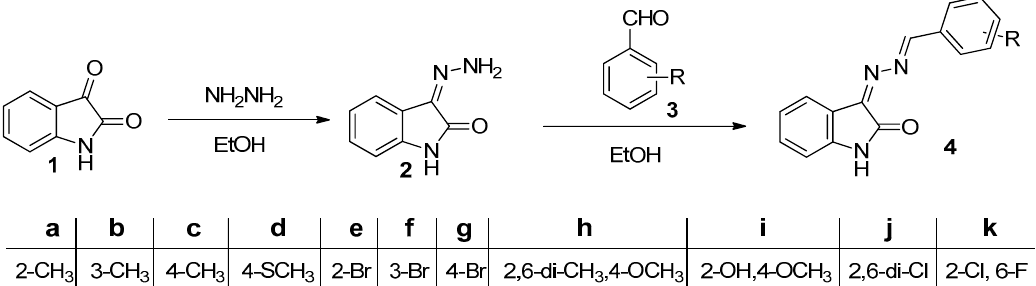
Figure 1. Isatin moiety containing active and potential drugs.